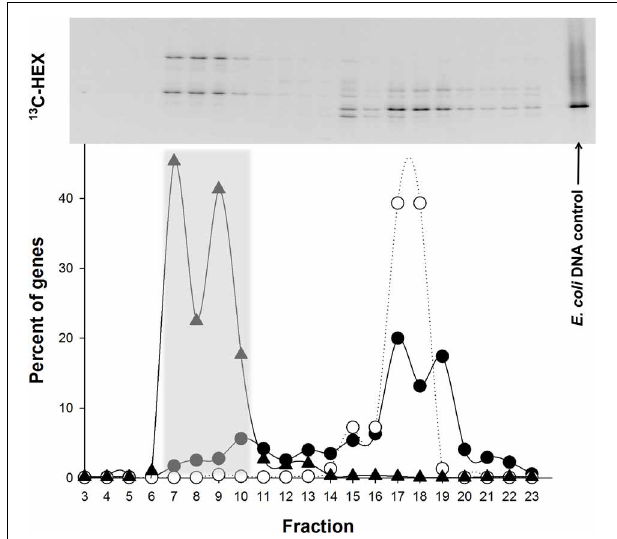
FIGURE 2 | Distribution of the “heavy” and “light” DNA in separated SIP fractions. (Top) DGGE image of bacterial PCR products from separated [ 13 C] n -hexadecane fractions, with decreasing densities from left to right. The position of unlabeled E. coli DNA, which was used as an internal control in the isopycnic centrifugation, is shown on the right. (Bottom) Distribution of qPCR-quantified 16S rRNA gene sequences is shown below the DGGE image for Alcanivorax (triangles) and Methylophaga (solid circles) in fractions from the [ 13 C] n -hexadecane incubations. The distribution of qPCR-quantified 16S rRNA gene sequences for E. coli is also shown (open circles) in fractions from the 13 C incubation. Gene copies in a fraction are presented as a percentage of the total genes quantified in the displayed range of fractions. Data points are aligned with equivalent fractions of the DGGE image.